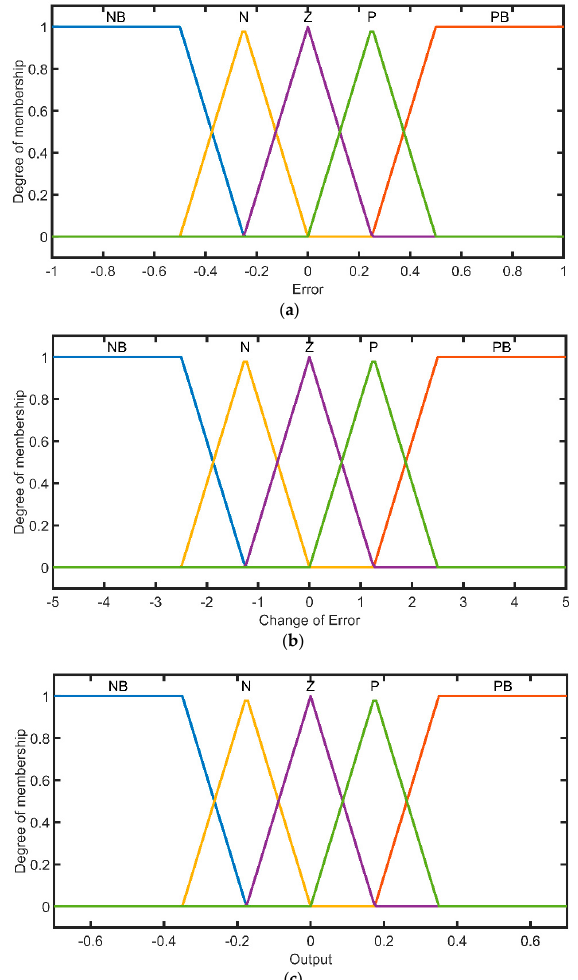
Figure 6. ( a ) The first input membership function. ( b ) The second input membership function. ( c ) Output membership function. Table 2. Rules for the proposed controller.